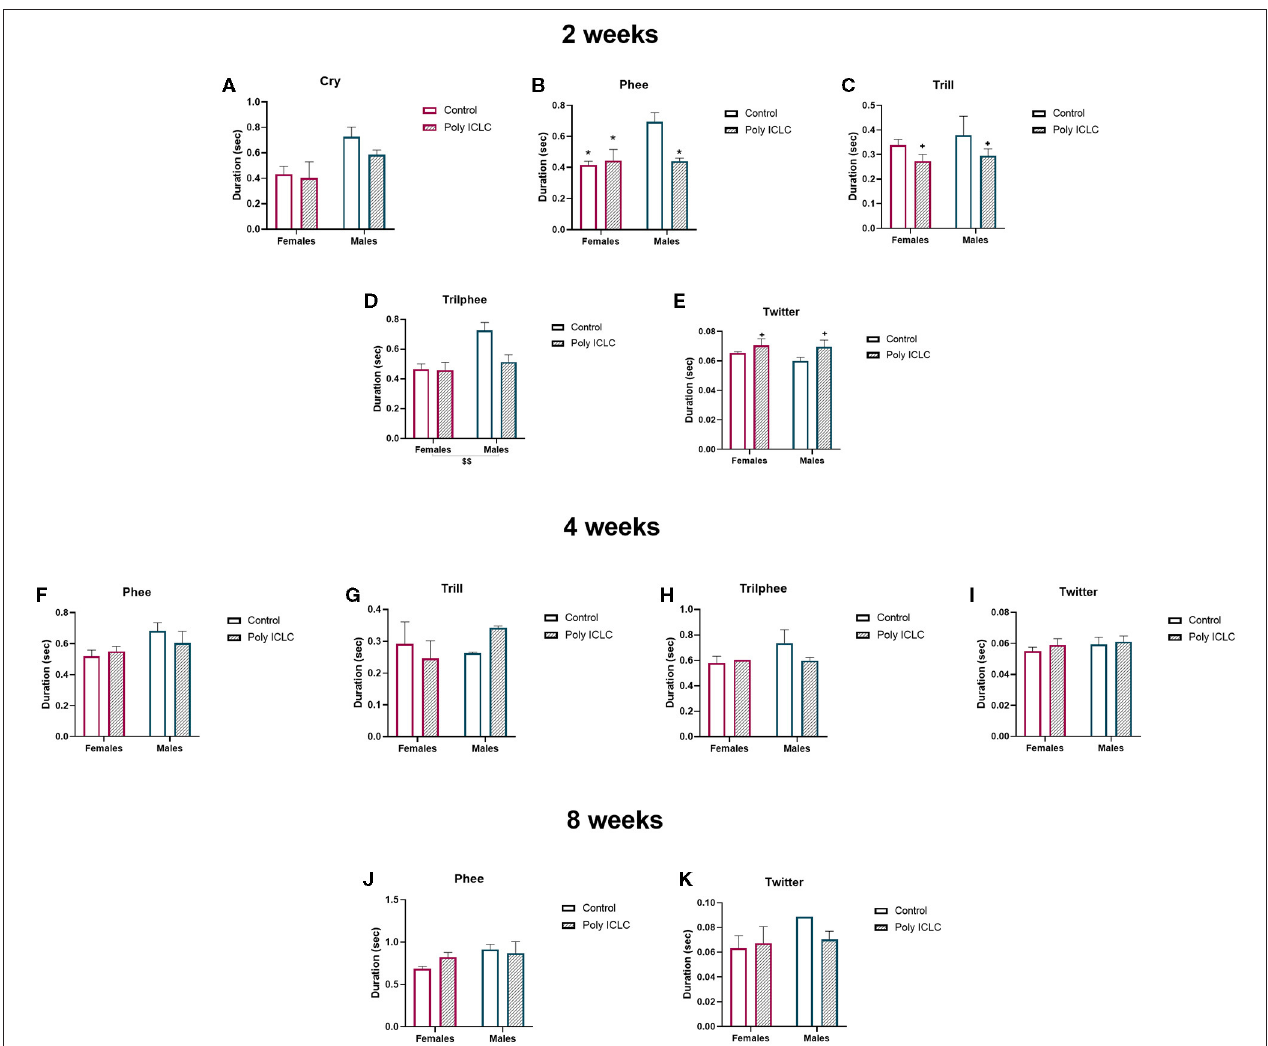
FIGURE 7 | Duration of the different types of vocalizations is affected by MIA and sex at 2 weeks of age. Duration of each vocalization type at (A–E) 2 weeks of age, (F–I) 4 weeks of age, or (J,K) 8 weeks of age. Control female n = 6, Poly IC females n = 4, Control males n = 2, Poly IC males n = 3. Data are expressed as mean ± SEM and analyzed by Two-way ANOVA with Bonferroni post-hoc . Significant differences are indicated by * p < 0.05 vs. Male Control. Main effect of treatment + p < 0.05. Main effect of sex $$ p <